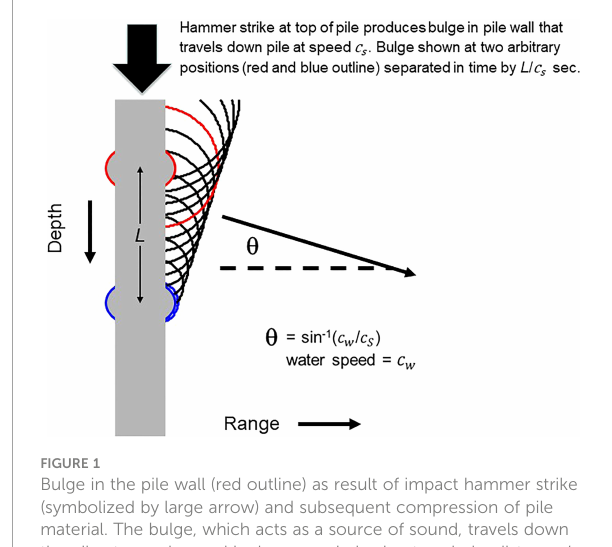
FIGURE 1 Bulge in the pile wall (red outline) as result of impact hammer strike (symbolized by large arrow) and subsequent compression of pile material. The bulge, which acts as a source of sound, travels down the pile at speed c s and is shown again having traveled a distance L (blue outline). Wave fronts from the earlier emission (red) and later emission (blue) are shown with all prior emissions (black); these adding to form a quasi-planar wave front characterized by angle q m